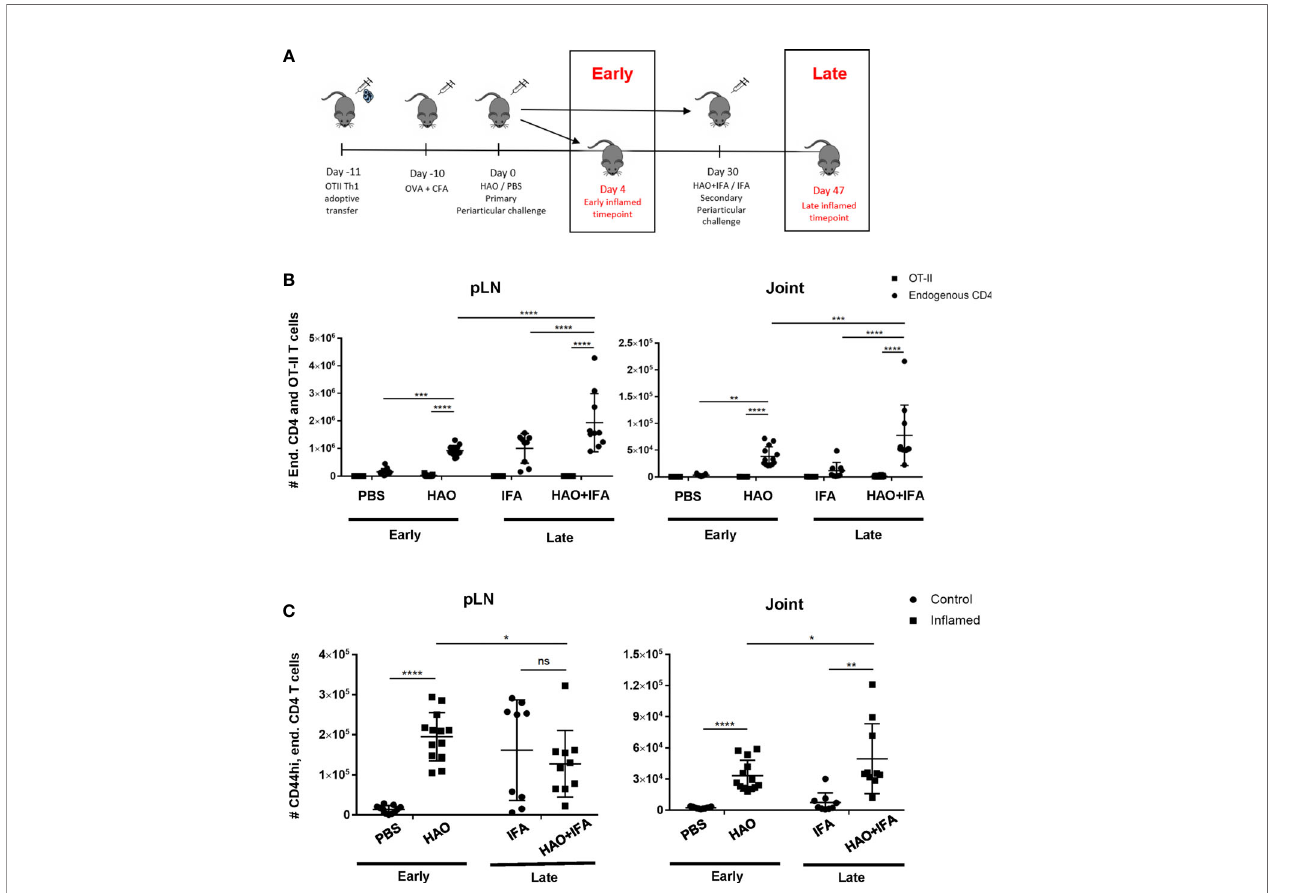
FIGURE 1 | Outline of model phases and number of endogenous, OT-II, and endogenous antigen experienced CD4 T cells at both phases. (A) Illustration of early and late phases of in fl ammatory arthritis. (B) Number of endogenous CD4 T cells (CD4+, CD45+, CD45.1-) and OT-II T cells (CD4+, CD45+, CD45.1+) from pLNs and joints of mice undergoing in fl ammatory arthritis at the early and late phases and respective controls. (C) Number of antigen experienced endogenous CD4 T cells (CD4+, CD45+, CD45.1-, CD44hi) from pLNs and joints of mice undergoing in fl ammatory arthritis at the early and late phases and respective controls. Data is representative of mean ± SD with each point representing individual experimental mice. Data represents three independent experiments for the early phase and two independent experiments for the late phase with n=5 for each experiment. Groups were compared using 2-way ANOVA and Student ’ s t-tests. Stars represent the following p-values: *<0.05, **<0.01; ***<0.001; ****<0.0001; ns, not signi fi cant. HAO, heat-aggregated OVA; IFA, incomplete Freund ’ s